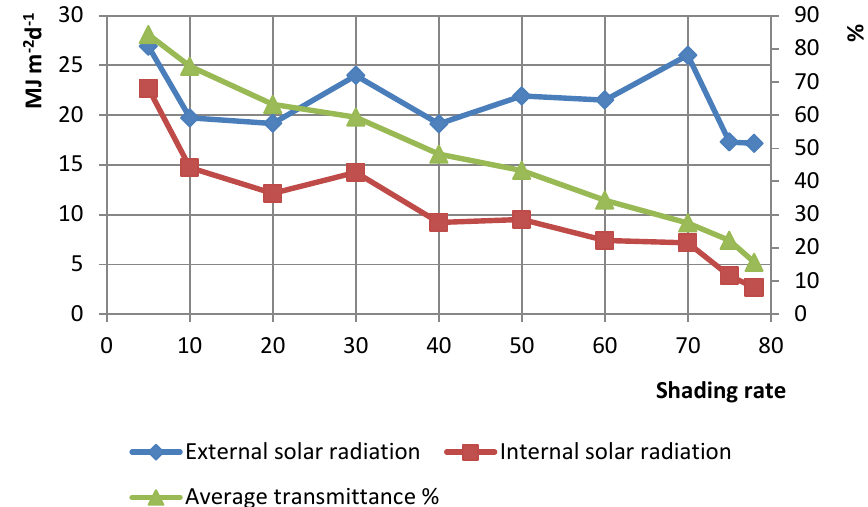
Figure 8. Outside and inside global solar radiation at different shading percentages.